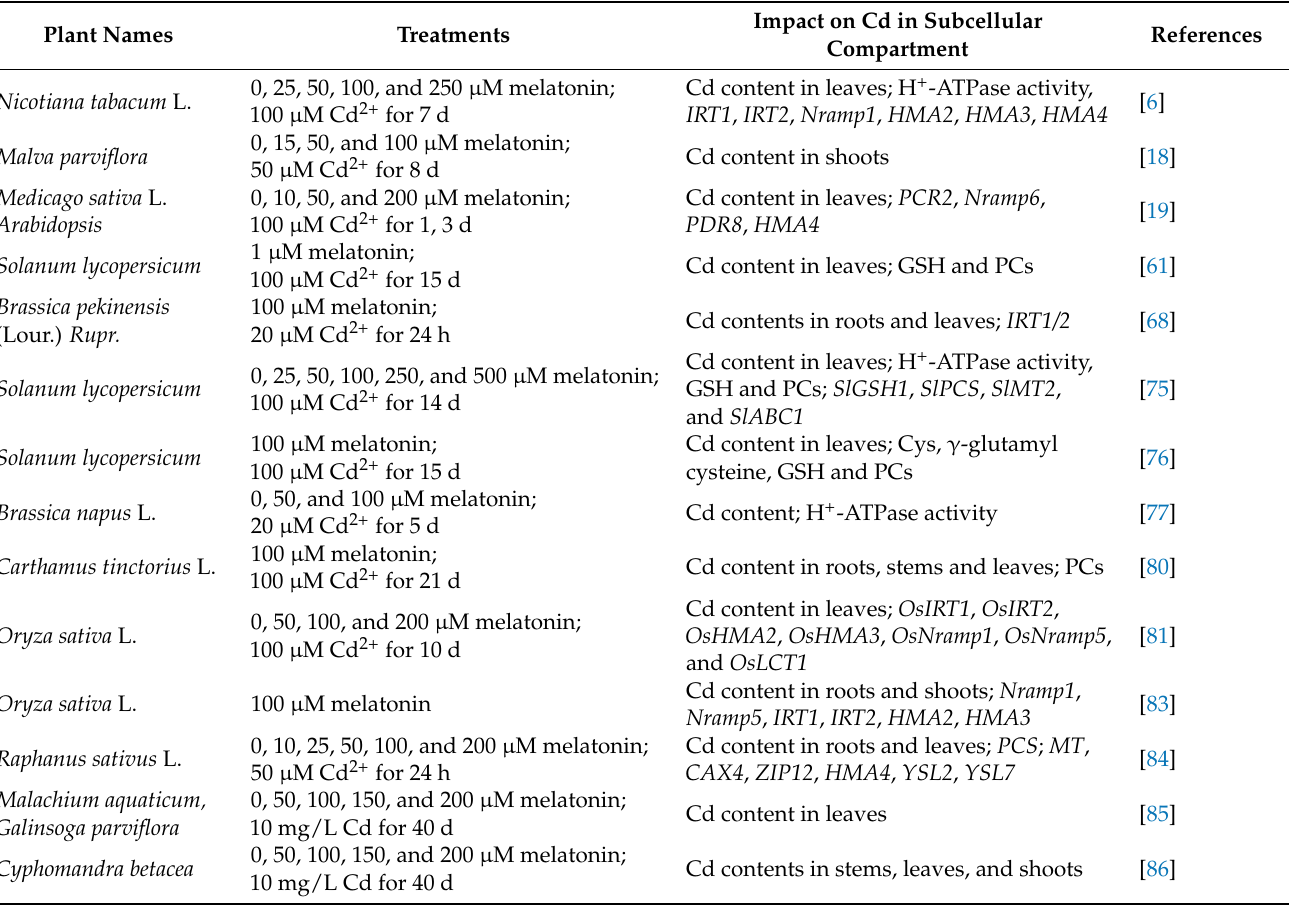
Table 3. Summary table explaining the impacts of melatonin on Cd uptake and translocation. Impact on Cd in Subcellular Treatments